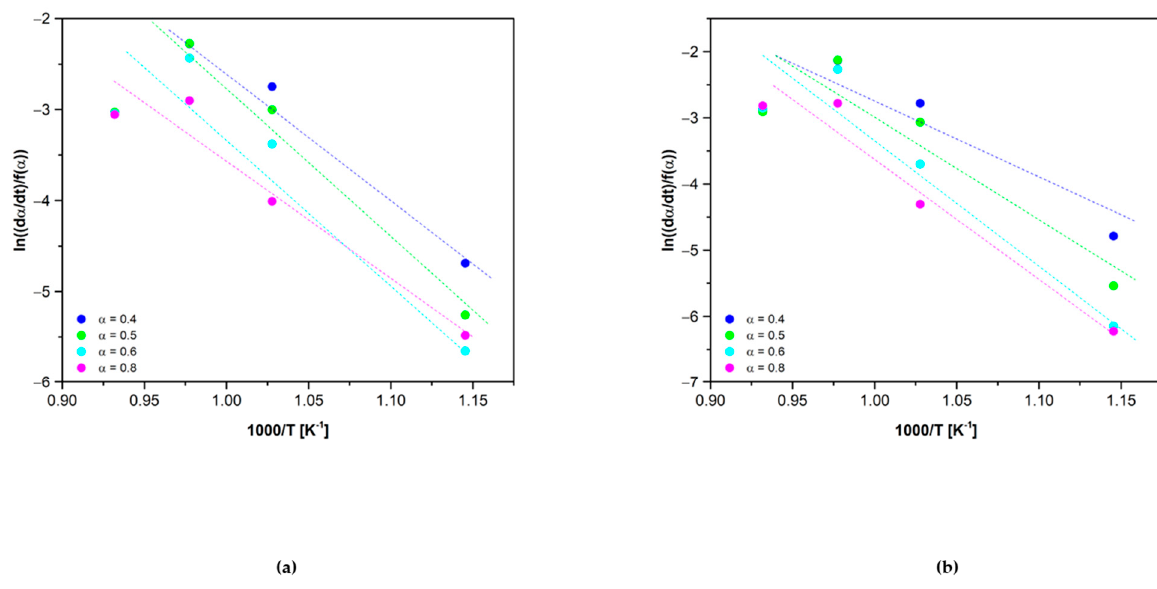
Figure 8. Friedman plots of ( a ) Co 2.4 Ni 0.6 O 4 and ( b ) 0.5% SiO 2 /Co 2.4 Ni 0.6 O 4 at different α